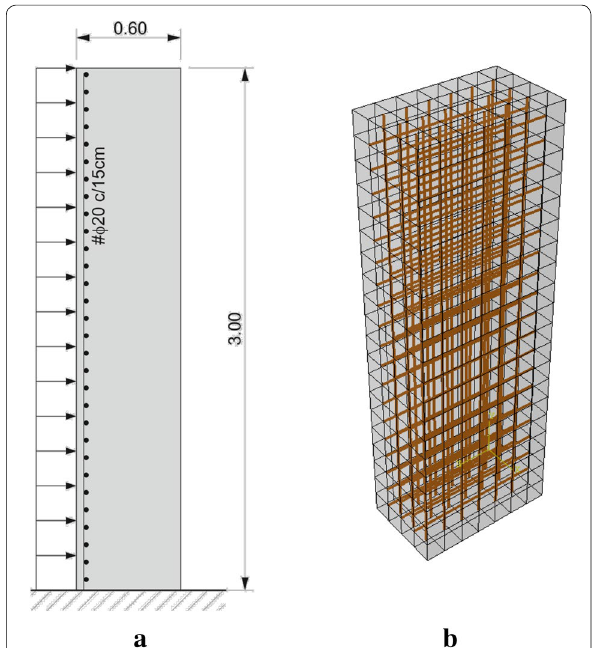
Fig. 13 Retaining wall under consideration: a scheme and b finite element model assembly.